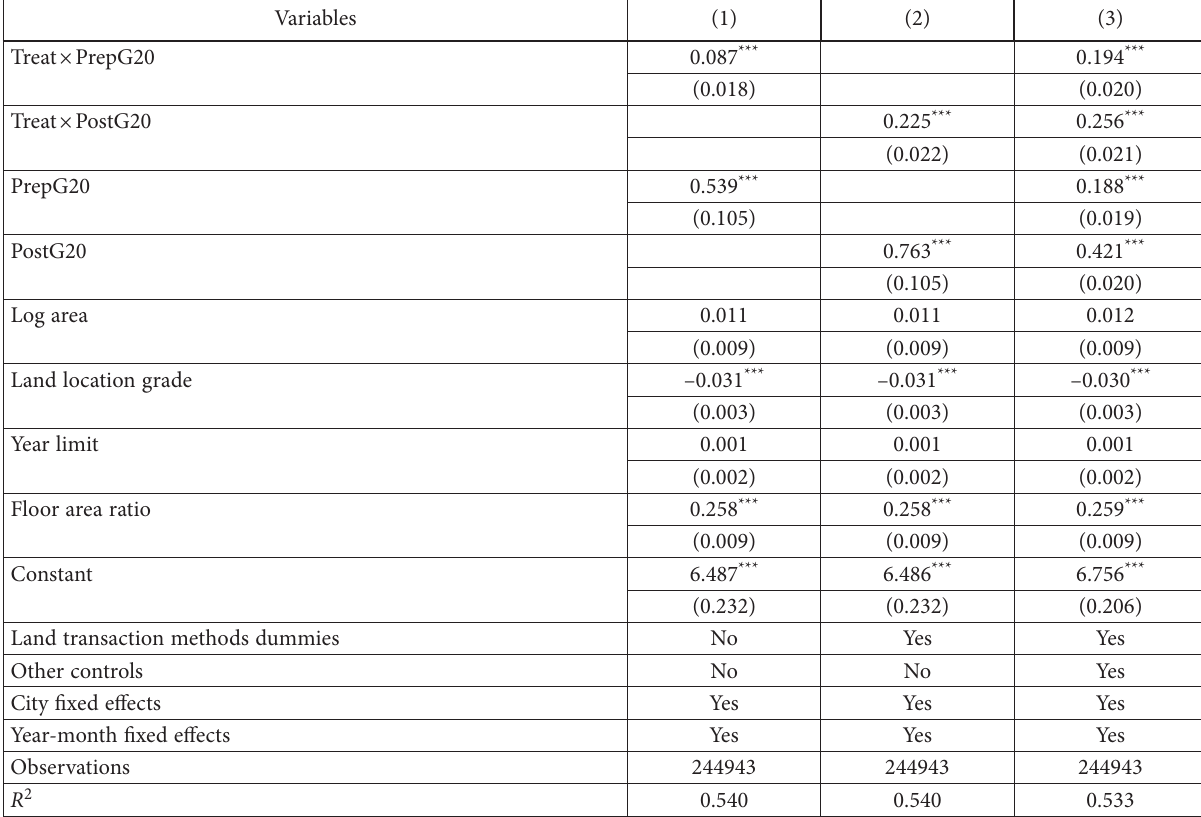
Table 3. Time varying effects of hosting the G20 Summit on land prices